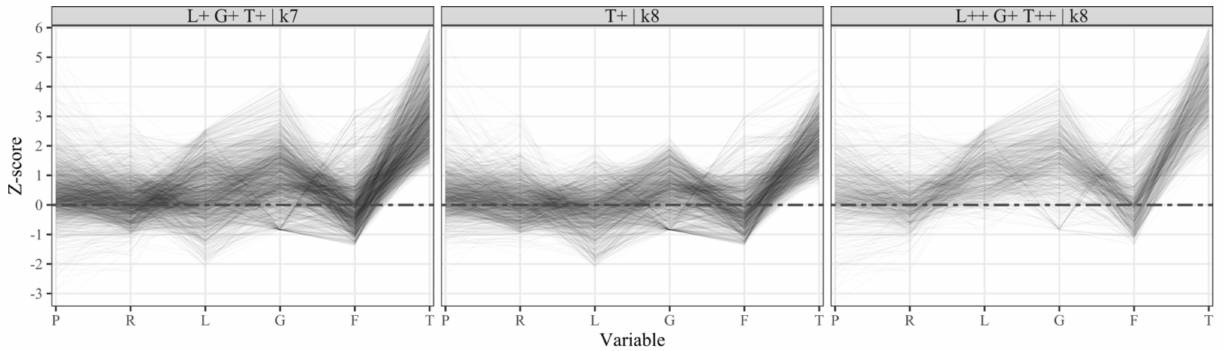
Figure 7. In the eight-cluster partitioning, the old L+G+T+ cluster ( left ) splits into two similar clusters ( right ) T+ and